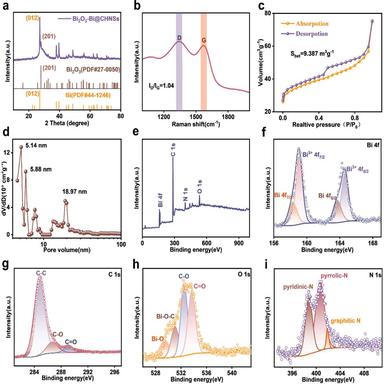
a) XRD patterns of Bi2O3-Bi@CHNSs. b) Raman spectrum of Bi2O3-Bi@CHNSs. c–d) Nitrogen adsorption–desorption isotherms and Pore distribution of Bi2O3- Bi@CHNSs. e) XPS survey spectrum of Bi2O3-Bi@CHNSs. f–i) High-resolution of Bi 4f, C 1s, O 1s and N 1s of Bi2O3-Bi@CHNSs.